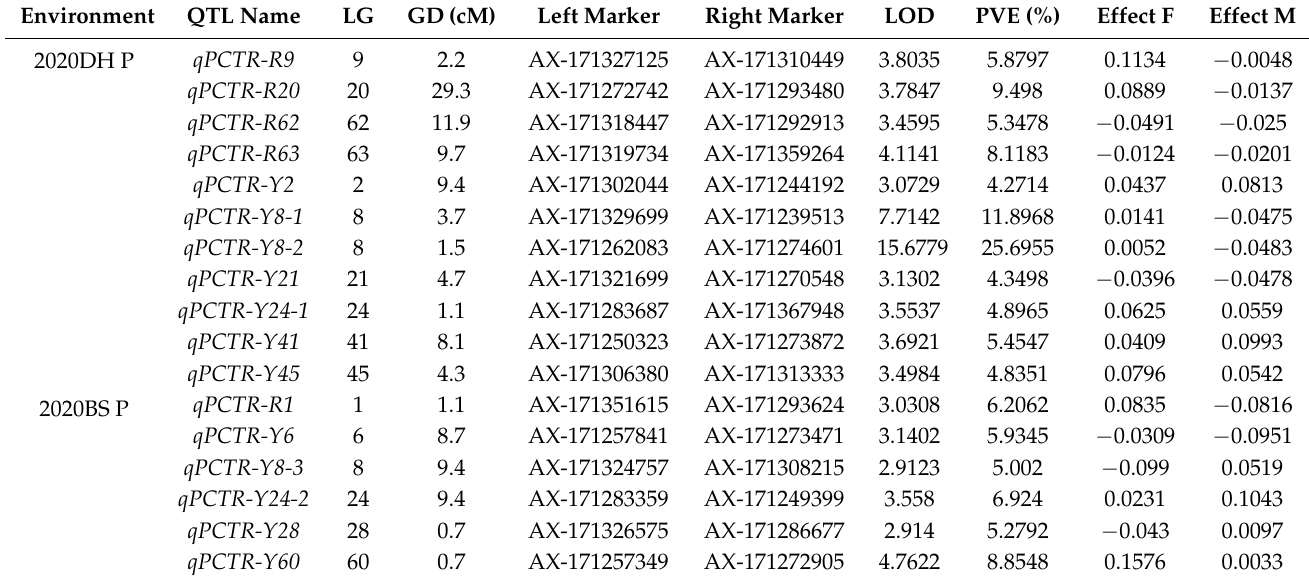
Figure 4. Correlation analysis of the tillering rate and the ratoon sprouting rate of the F 1 population in the plant cane and ratoon cane under different environments. *, ** and *** indicates significant difference at the 0.05, 0.01 and 0.001 levels, respectively; p , I and II represent the tillering rate in the plant cane, and the ratoon sprouting rate in the first and second ratoon cane, respectively. Table 2. QTLs for the tillering rate of F 1 population derived from YT93-159 × ROC22 in the plant